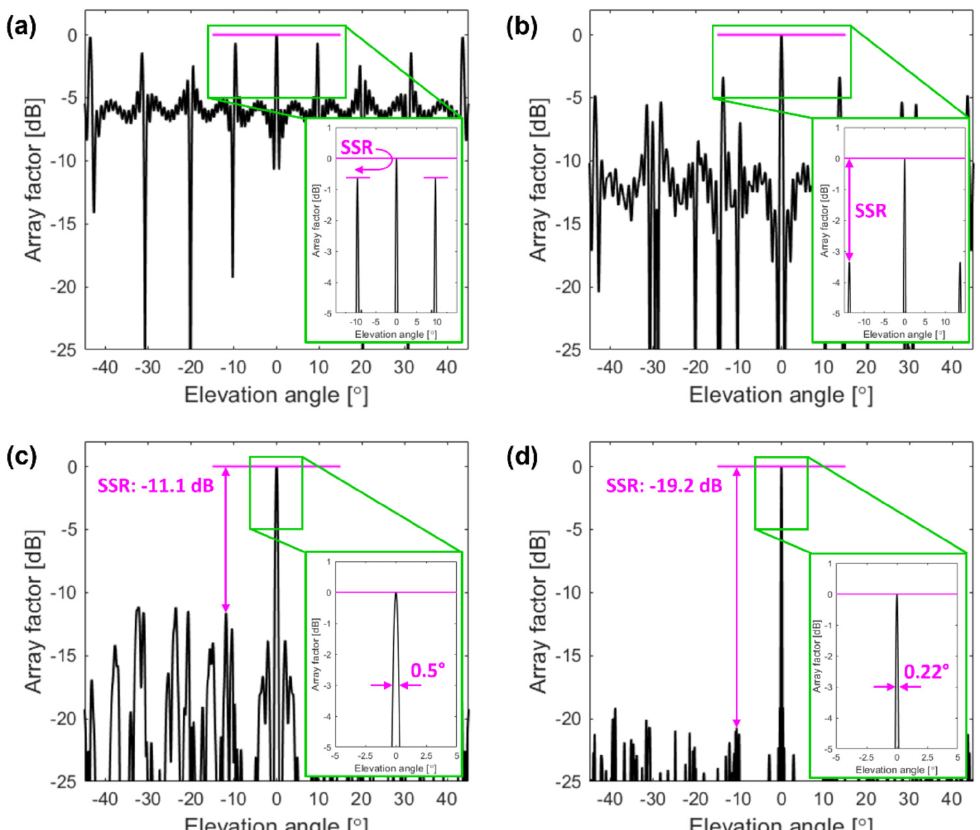
Figure 3. Simulated array factor for different optical phased arrays. Elevation cut ( Φ = 0°) of the array factor amplitude for designs with ( a ) N = 10, M = 4, R 0 = 20 μm, and dr = 9 μm; ( b ) N = 10, M = 8, R 0 = 20 μm, and dr = 9 μm; ( c ) N = 10, M = 11, R 0 = 20 μm, and dr = 9 μm ( Array #1 ); and ( d ) N = 20, M = 41, R 0 = 60 μm, and dr = 9 μm ( Array #2 ). Figure insets show the enlarged view of an array factor with an elevation angle θ in a −5 ° to 5° range.